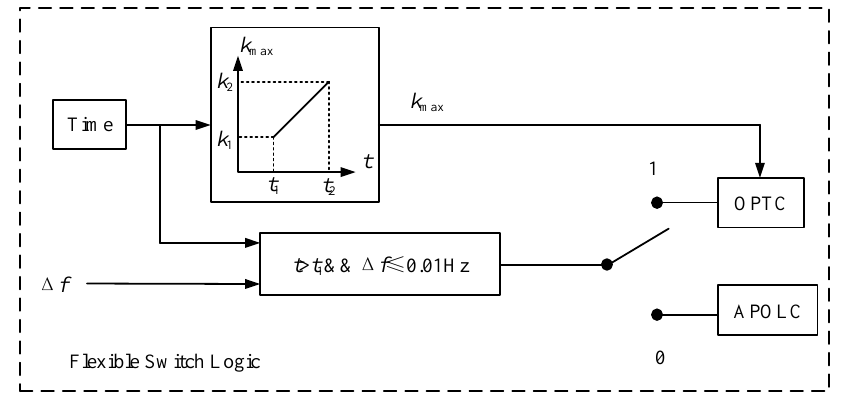
Figure 9. Flexible switch logic of OPTC and APOLC.